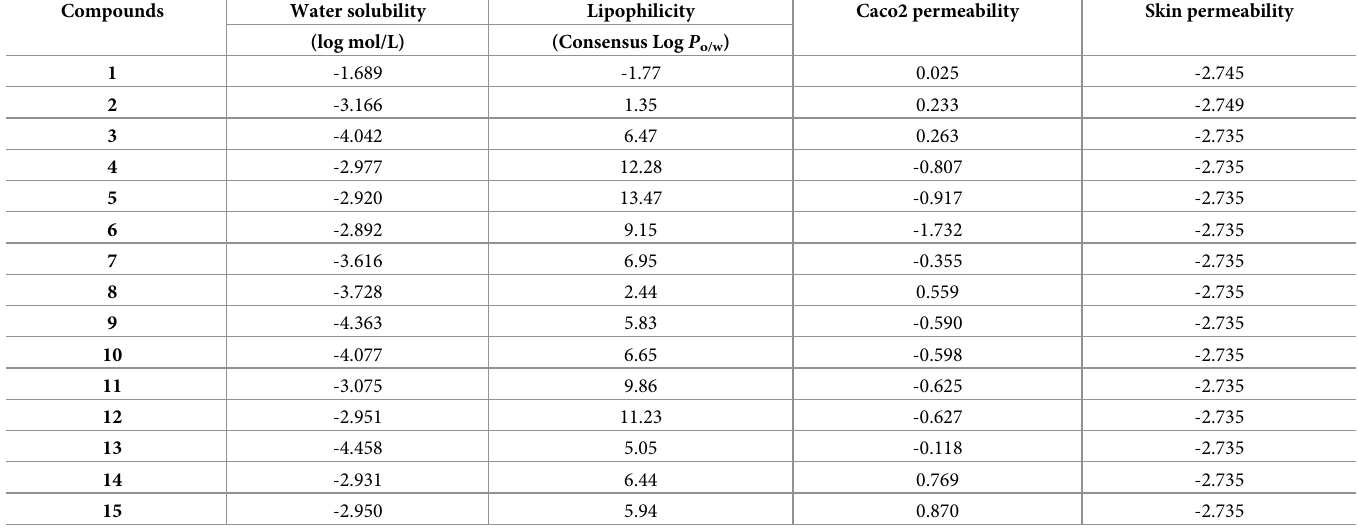
Table 3. Prediction in silico of absorption of cytidine